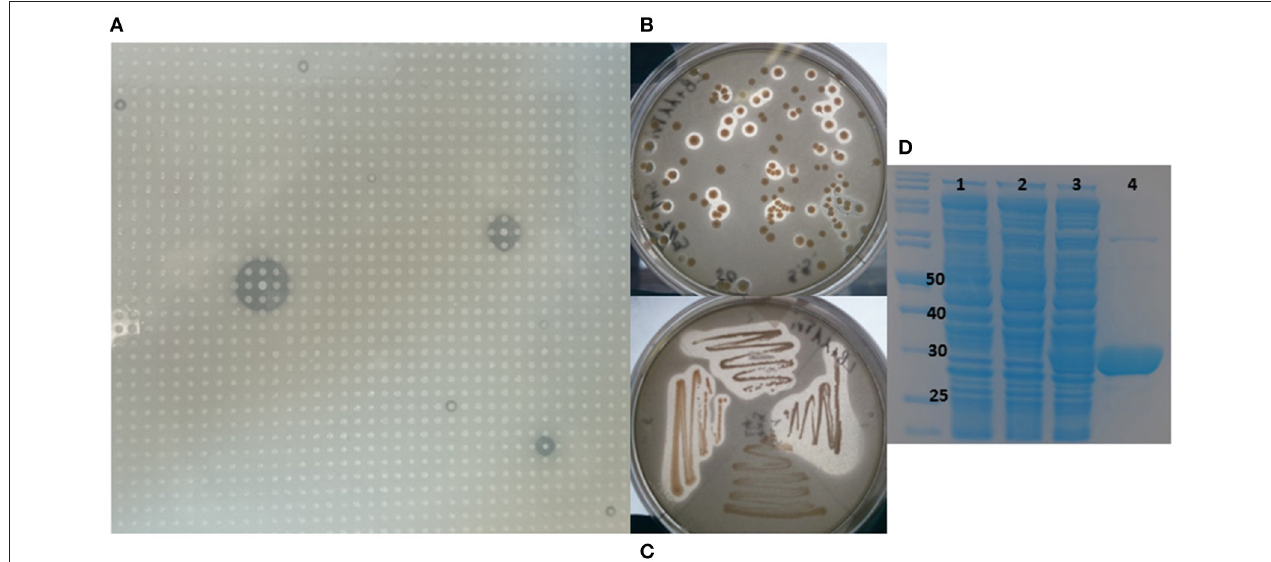
FIGURE 1 | Metagenomic screening, cloning, and purification of 7N9 esterase. (A) Metagenomic library of Stelletta normani plated onto 1% tributyrin agar. (B) Lipase activity of E. coli clones carrying the 7N9 esterase gene on pBAD plasmid. (C) Restreak of active clones, (D) SDS-PAGE analysis of the expression and purification of 7N9 esterase, first lane marker, lane 1 (0.02% arabinose) E. coli culture with empty pBAD expression vector, lane 2 uninduced E. coli culture with pBAD harboring 7N9, lane 3 induced (0.02% arabinose) E. coli with pBAD harboring 7N9, lane 4 partial purification of 7N9 esterase using Ni-NTA